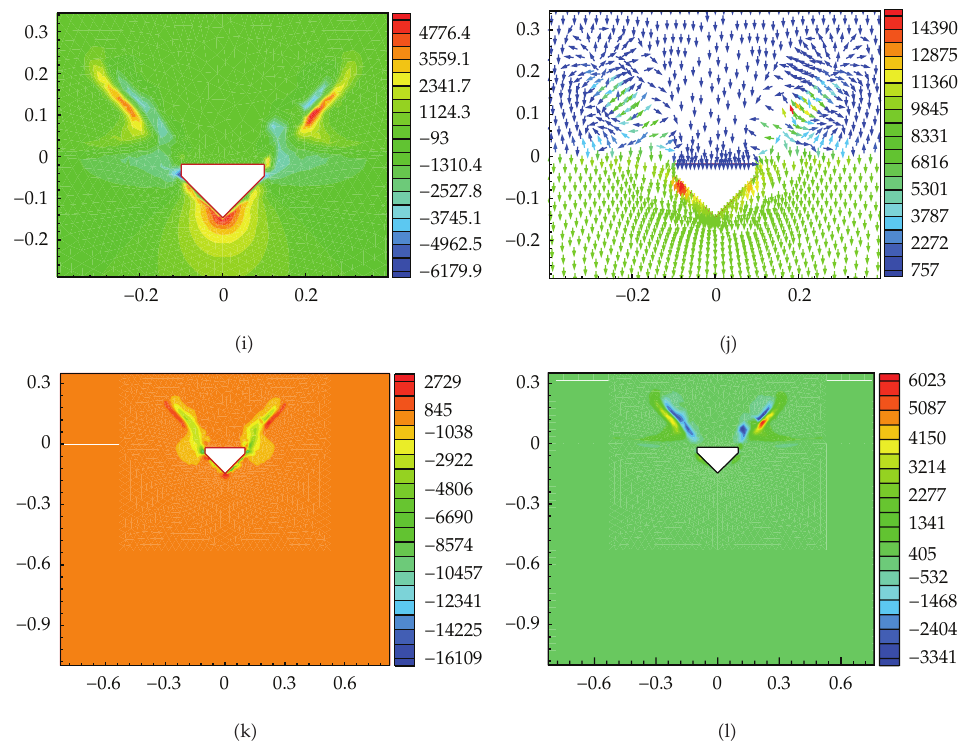
Figure 12: Microscopic details of fluid energy at t (cid:9) 0 . 27s. (cid:2) a (cid:3) free surface profile; (cid:2) b (cid:3) velocity vector; (cid:2) c (cid:3) convection of kinetic energy; (cid:2) d (cid:3) convective vector of kinetic energy (cid:2) high to low (cid:3) ; (cid:2) e (cid:3) work done by pressure; (cid:2) f (cid:3) convective vector of pressure; (cid:2) g (cid:3) work done by gravity; (cid:2) h (cid:3) gravity vector; (cid:2) i (cid:3) convection of potential energy; (cid:2) j (cid:3) convective vector of potential energy; (cid:2) k (cid:3) transient change of kinetic energy; (cid:2) l (cid:3) transient change of potential